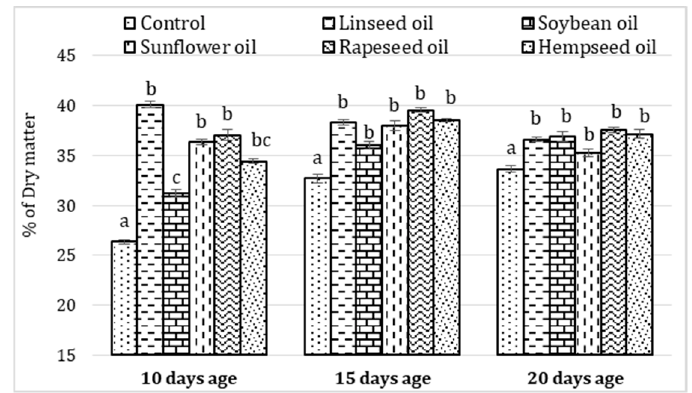
Figure 2. The effects of vegetable oil addition in the Hermetia illucens larvae diets on the crude fat content (% of DM) at three age categories (Mean ± SE). Different letters (a–c) above means indicate significant differences ( p < 0.05).